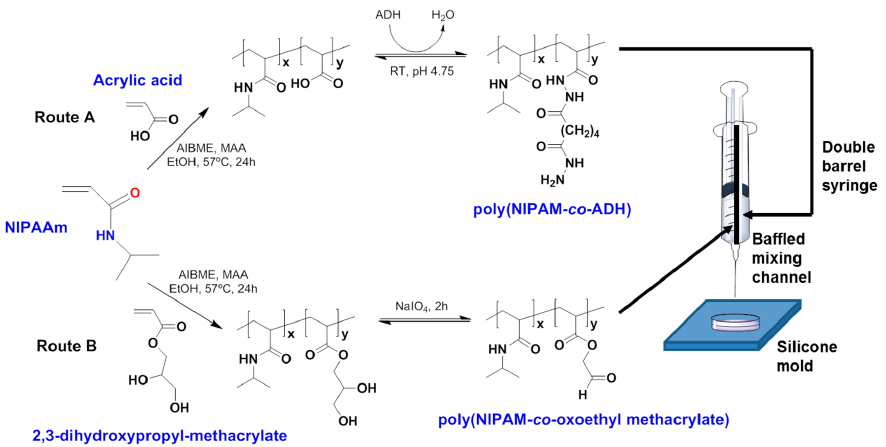
Figure 14. Scheme of the synthesis of hydrazide-functionalized precursor copolymers (PNIPAAm- co -ADH) (Route A) and aldehyde-functionalized precursor copolymers (PNIPAAm- co -oxoethyl methacrylate) (Route B). ADH is the acronym of adipic acid dihydrazide compound used as reversible and rapid functionalization of PNIPAAm oligomers. Adapted with permission from Reference [76]. Copyright © 2012 American Chemical Society.